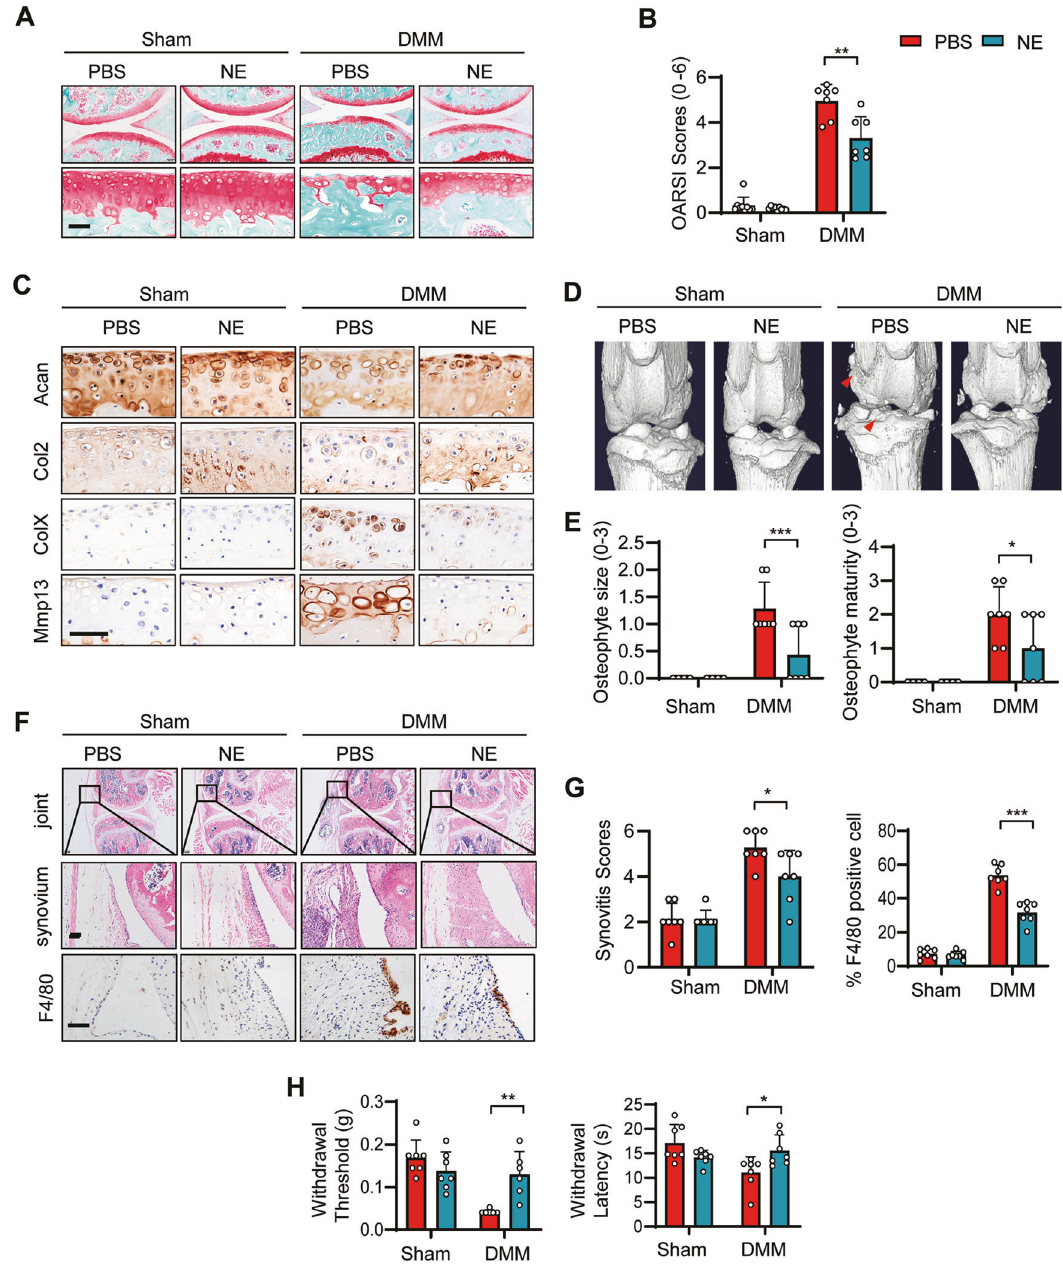
Fig. 4 Pharmaceutical inhibition of GPR4 suppressed the progression of OA. A , B Representative images of Safranin-O staining of the knee joint at 6 weeks after DMM surgery. The mice were IA injected with 10 μ l PBS or NE52-QQ57 (NE, 30 μ M) two times per week. Six weeks later, the mouse joints were collected and subjected to staining ( A ). The corresponding OARSI scores were analyzed ( B ). n = 7 mice per group. Data are presented as mean ± s.d. ** p < 0.01, using two-way ANOVA followed by Tukey ’ s post hoc test. Scale bar, 50 μ m. C Representative images of IHC staining (for anabolic factors Acan and Col2, catabolic factors Mmp13 and ColX) of sections from PBS or GPR4 antagonist NE52-QQ57 (NE) IA injected mice ( C ). Scale bars, 50 μ m. D Representative three-dimensional micro-CT images of the knee joints in sagittal view. The red arrows indicate osteophytes. E Osteophyte formation was scored by assessing osteophyte size (left) and maturity (right) from PBS or GPR4 antagonist NE52-QQ57 (NE) IA injected mice. Six weeks post DMM surgery, the mouse joints were collected and subjected to osteophyte score analysis. n = 7 mice per group. Data are expressed as mean ± s.d. * p < 0.05, *** p < 0.001 two-way ANOVA followed by Tukey ’ s post hoc test was used for statistical analysis. F Treatment of GPR4 antagonist NE52-QQ57 (NE) relieved synovial in fl ammation and microphage in fi ltration in an OA mouse model. Six weeks after DMM surgery, mouse joints were collected and subjected to H&E and F4/80 IHC staining. Scale bars, 50 μ m. G Synovitis scores were evaluated based on H&E staining ( G left, n = 7) and F4/80 positive cells were quanti fi ed ( G right, n = 7). Data are expressed as mean ± s.d. * p < 0.05, *** p < 0.001 by two-way ANOVA followed by Tukey ’ s post hoc test. H Von Frey assay (left) and thermal hyperalgesia test (right) were performed 6 weeks after DMM surgery with PBS or NE52-QQ57 (NE) treatment ( n = 7). Data are presented as mean ± s.d. * p < 0.05, using two-way ANOVA followed by Tukey ’ s post hoc